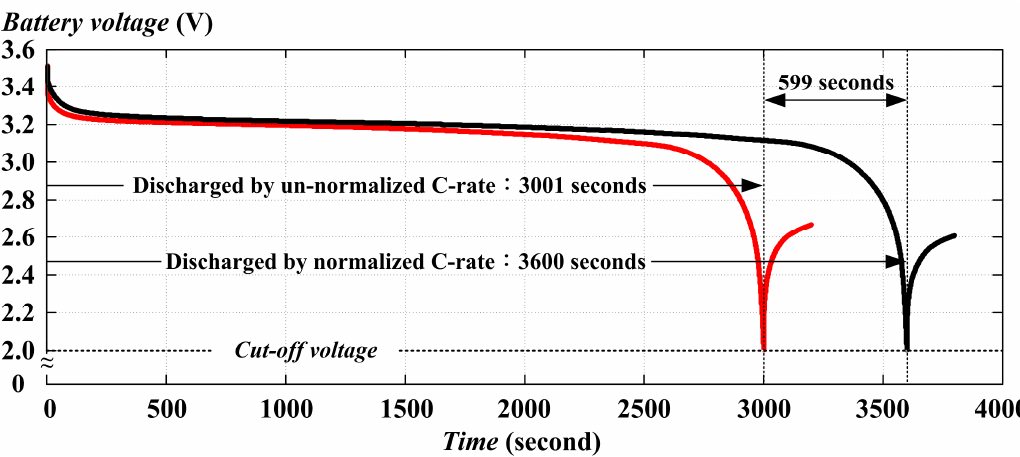
Figure 1. The voltage and the discharging time under a rate of 1 C.